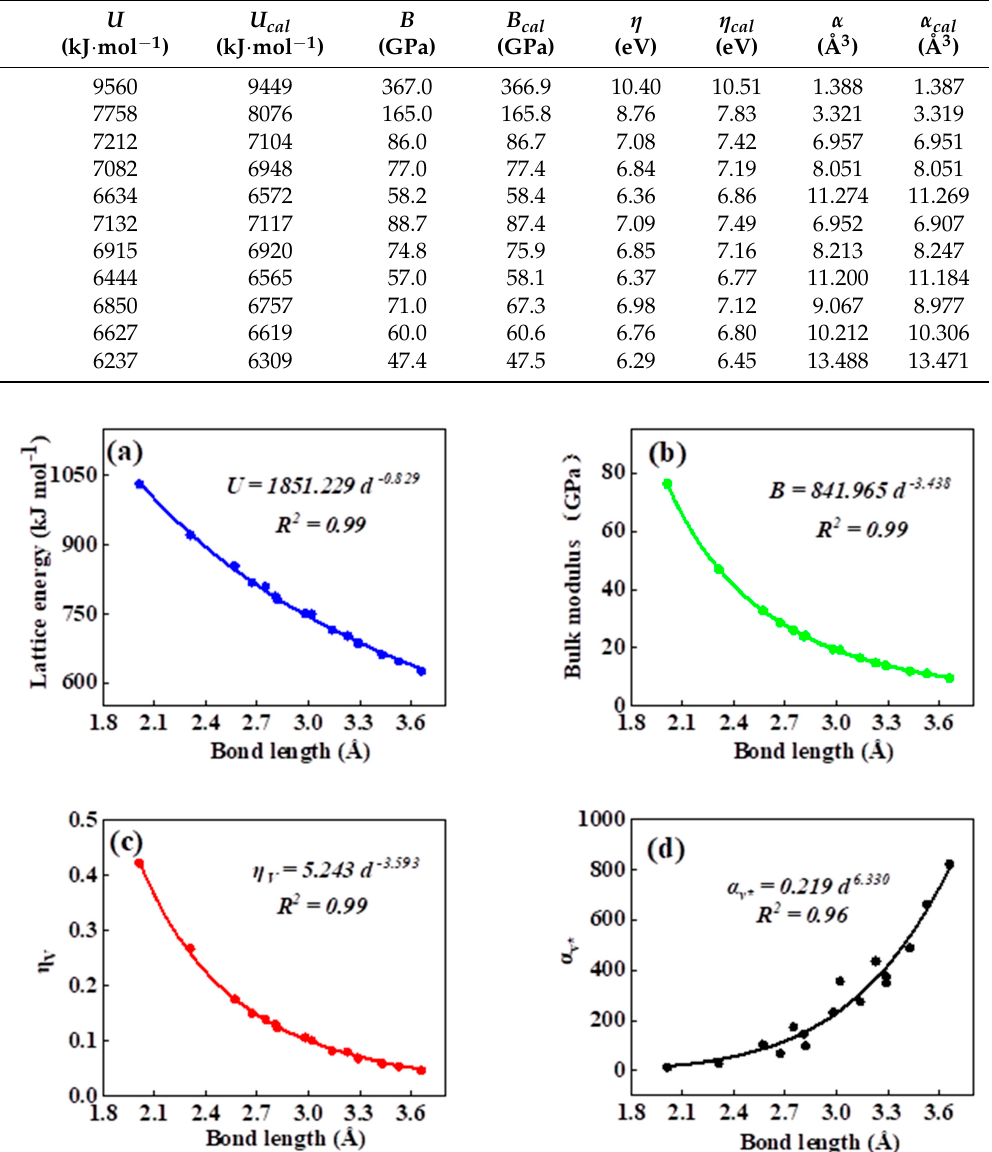
Table 4. Chemical bond length d , molar volume V m , lattice energy U , calculated lattice energy U cal , bulk modulus B and calculated bulk modulus B cal , chemical hardness η , calculated chemical hardness